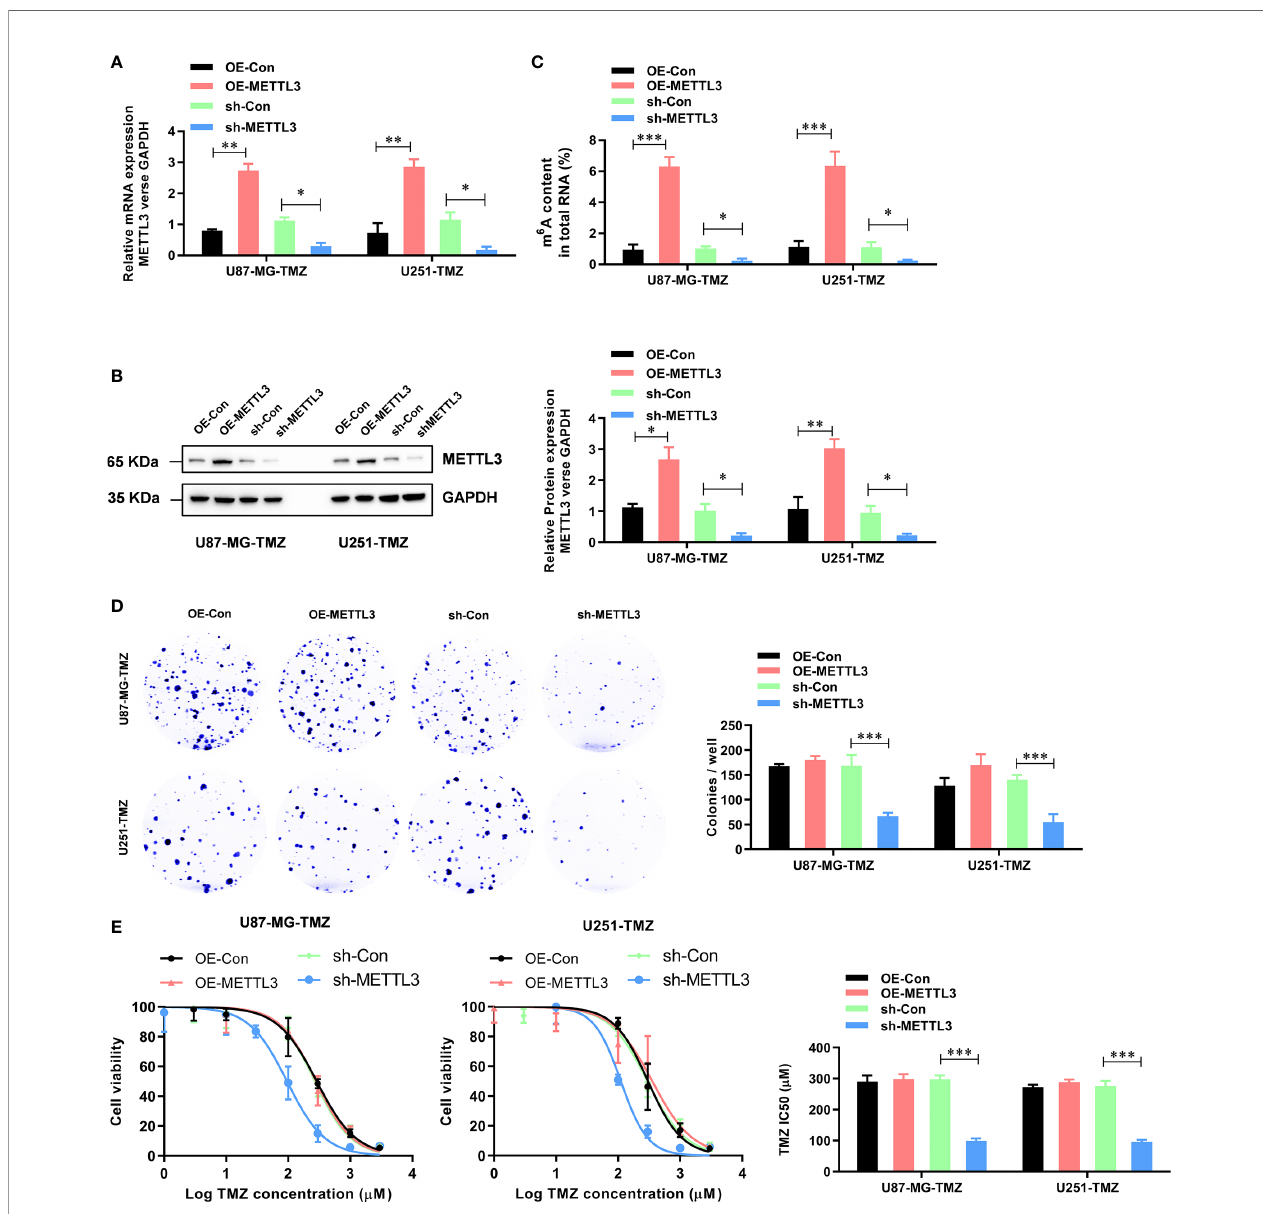
FIGURE 2 | METTL3 contributes to the TMZ resistance in GBM cells. (A) The ef fi ciency of overexpression and knockdown on the mRNA levels of METTL3 were analyzed by qRT-PCR. (B) The ef fi ciency of overexpression and knockdown on the protein levels of METTL3 were analyzed by western blot. (C) The effect of METTL3 overexpression and knockdown on the total m 6 A RNA level was analyzed by the colorimetric m 6 A quanti fi cation assay. (D) The effect of METTL3 overexpression and knockdown on the cell proliferation was analyzed by the colony formation assay. (E) The effect of METTL3 overexpression and knockdown on the sensitivity to TMZ was analyzed by CCK-8 assay. * P < 0.05, ** P < 0.01, and *** P < 0.001 versus indicated control U87-MG/U251